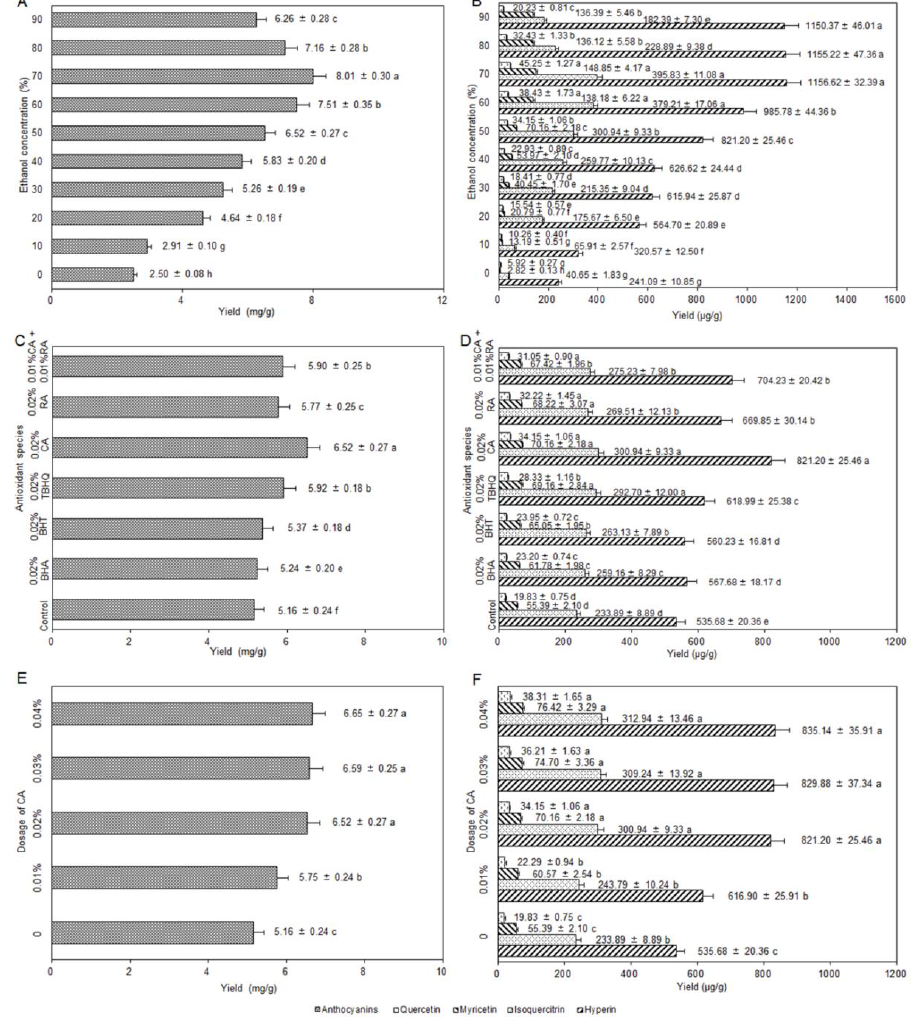
Figure 2. Influence of ethanol concentration on the extraction yields of anthocyanins ( A ) and flavonols ( B ); influence of antioxidant species on the extraction yields of anthocyanins ( C ) and flavonols ( D ); influence of dosage of CA on the extraction yields of anthocyanins ( E ) and flavonols ( F ). CA, carnosic acid; RA, rosmarinic acid; TBHQ, tert -butylhydroquinone; BHT, butylated hydroxytoluene; BHA, butylated hydroxyanisole.